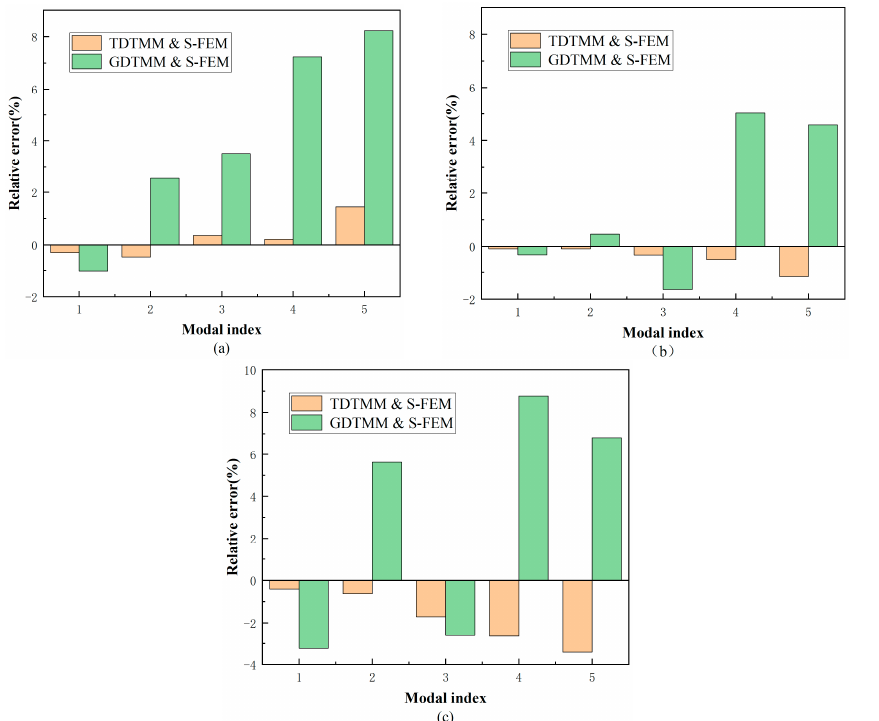
Figure 5. The plot of relative error on natural frequencies versus modal index for example 1 under different boundary conditions: ( a ) C-C; ( b ) C-F; ( c ) F-F.